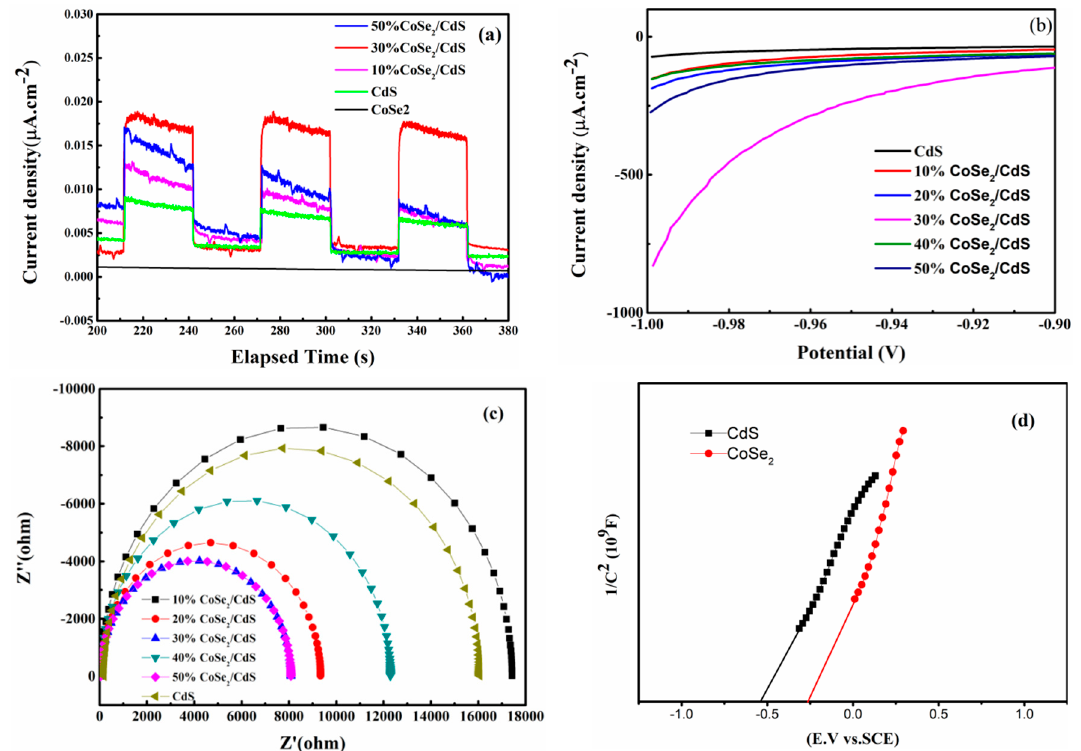
Figure 6. ( a ) The photocurrent curves of pure CdS and 10% CoSe 2 / CdS, 30% CoSe 2 / CdS, 50% CoSe 2 / CdS. ( b ) LSV curves of pure CdS and CoSe 2 / CdS ranging from 10–50%. ( c ) EIS under unilluminated condition of pure CdS and CoSe 2 / CdS ranging from 10–50%. ( d ) Mott–Schottky plots for CdS and CoSe 2 .